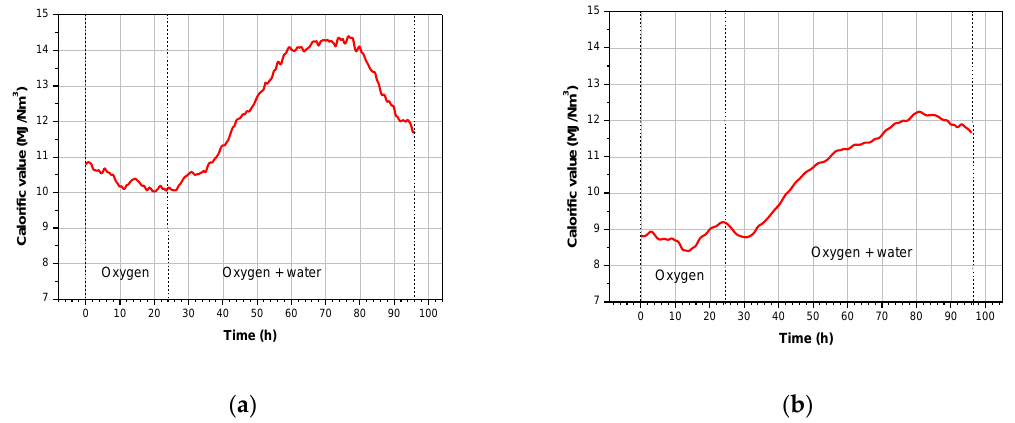
Figure 9. Changes in gas calorific value over the course of gasification experiments at 40 bar: ( a ) “Six Feet” semi-anthracite, ( b ) “Wesoła” hard coal.